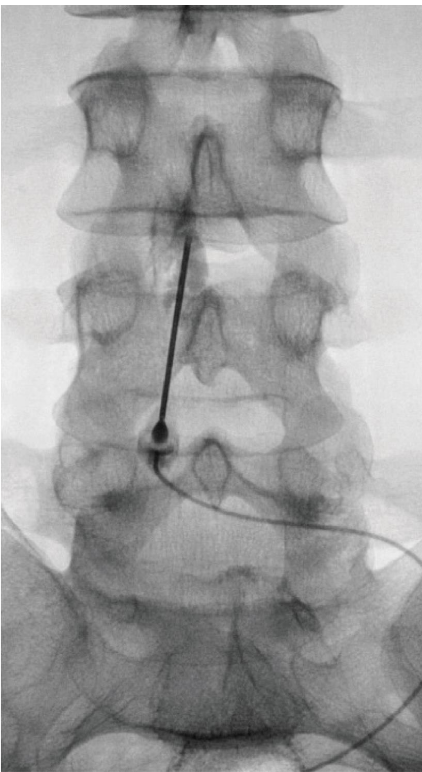
Figure 1: Te L3-L4 epidural space was accessed under fuoros- copy, and correct placement was confrmed with injection of